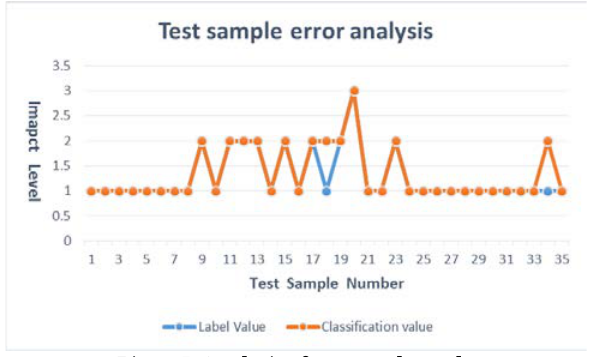
Figure 5. Analysis of test sample results